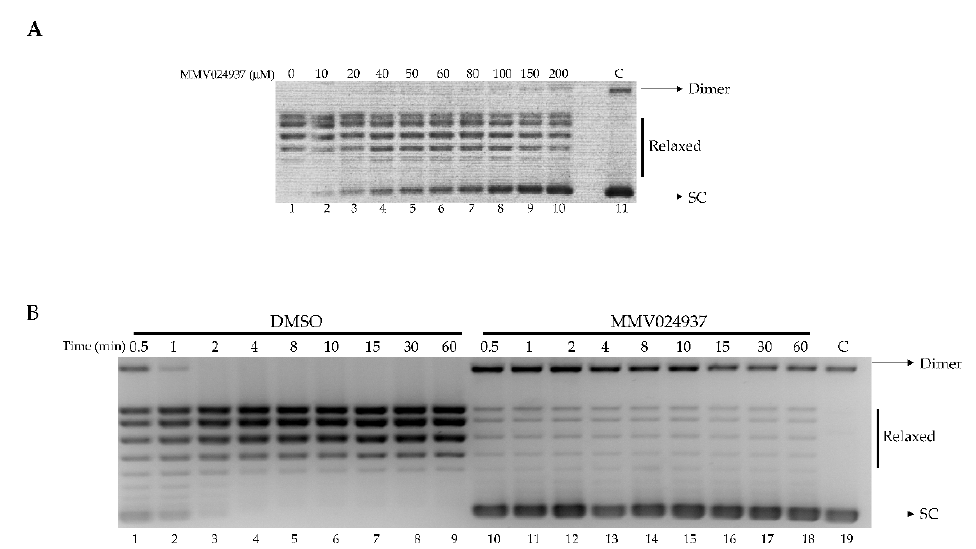
Figure 2. Relaxation of supercoiled DNA. ( A ) Relaxation of a negatively supercoiled plasmid DNA by htopIB at increasing concentrations of MMV024937 (lanes 2–10); lane 1: no drug added and lane 11: no protein added. ( B ) Relaxation of negative supercoiled plasmid DNA in a time course experiment with DMSO (lanes 1–9), 100 µM MMV024937 dissolved in DMSO (lanes 10–18), lane 19, no protein added. The reaction products are resolved on agarose gel and visualized with ethidium bromide. Dimer indicates dimer supercoiled plasmid DNA; SC indicates supercoiled plasmid DNA.